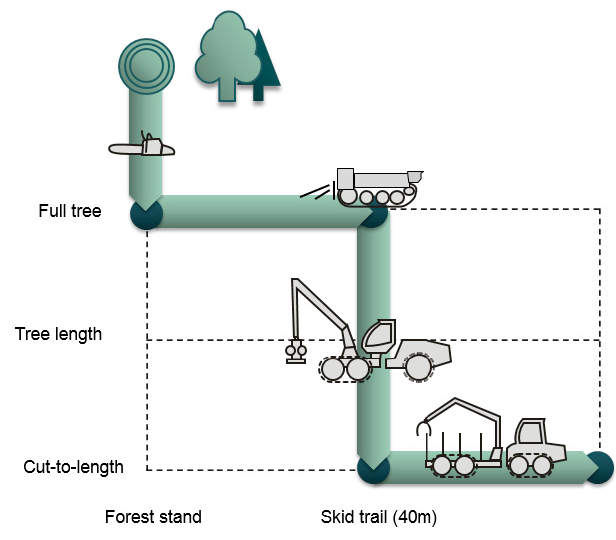
Figure 2. Representation of the wood harvesting and extraction operation.